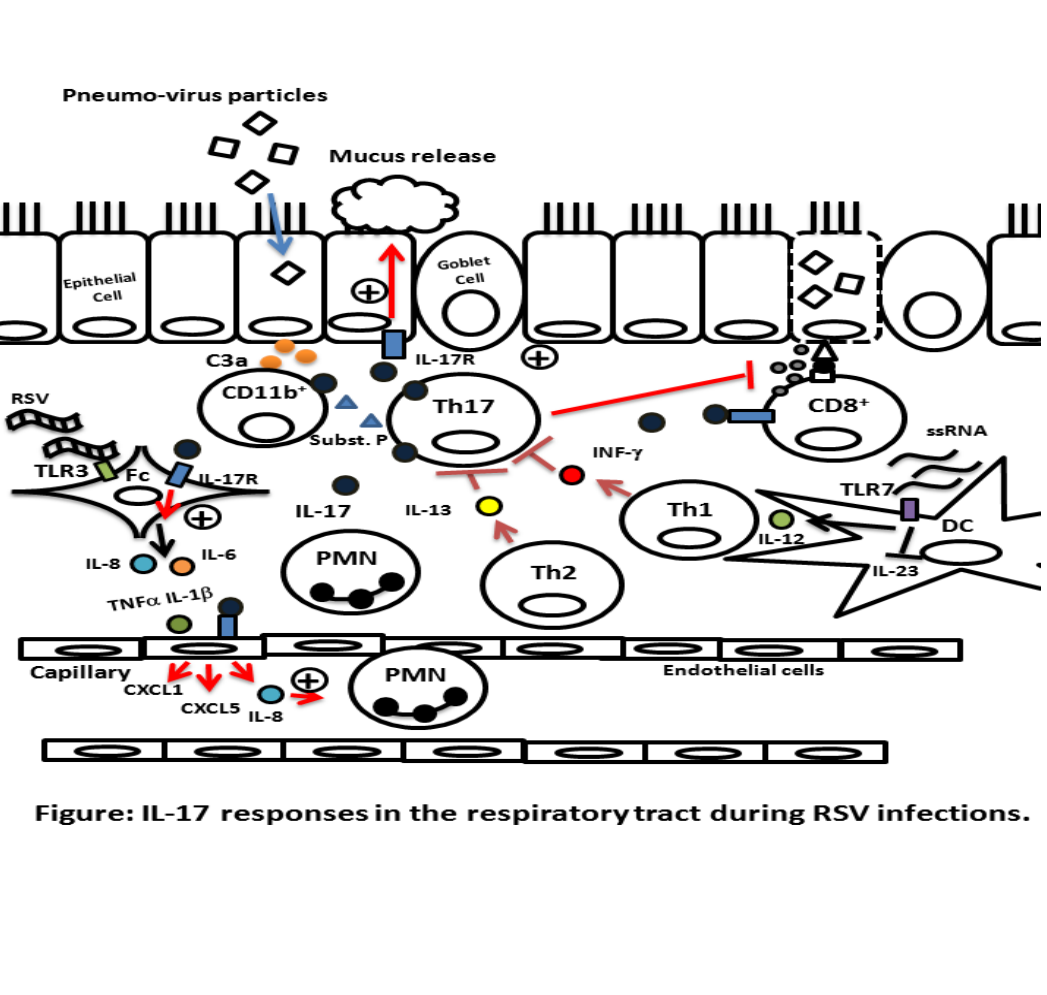
Figure 1. IL-17 mediated responses in the respiratory tract during RSV infections. RSV virus particles infect ciliated epithelial cells in the lower respiratory tract. C3a and other mediators of inflammation are then released from epithelial cells in response to the infection and this, in turn, induces IL-17 production (dark blue colour). During the early phase of the response to RSV infection, IL-17 is produced by CD11b + innate immune cells. Subsequently, the production of IL-17 is predominantly by CD4 + Th17 lymphocytes. The production of IL-17 initiates a number of effects in the respiratory tract. Thus, IL-17 induces mild inflammation and exacerbates inflammatory responses triggered by other signals and cytokines. In this scenario, single stranded RNA in RSV particles bind to TLR3 and synergize with IL-17 to induce IL-6 (orange colour) and IL-8 (blue colour) by fibroblasts (Fc). The binding of double stranded RNA to TLR7, however, is inhibitory to IL-17-mediated responses and, instead, promotes Th1-mediated responses. IL-17 co-operates with IL-1  and TNFα to induce the release of chemokines that mediate neutrophil recruitment. Furthermore, IL-17 induces mucus production from epithelial cells. IL-17 also binds receptors on CD8 + T lymphocytes and inhibits their ability to reduce viral load. Cytokines produced by Th1 and Th2 lymphocytes, IFN  and IL-13, in contrast, inhibit IL-17 production